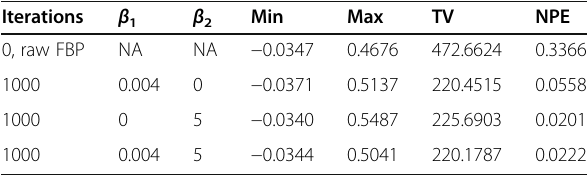
Table 5 Values of maximum, minimum, metal-free region TV, and NPE in reconstructions of bag #5